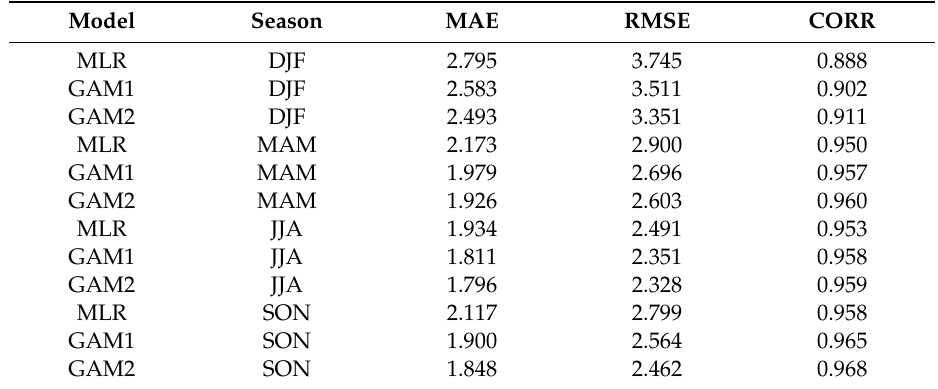
Table 2. Seasonal mean values of absolute mean errors (MAE), root mean square errors (RMSE), and Pearson’s correlation coe ffi cients (CORR) (2016–2017).